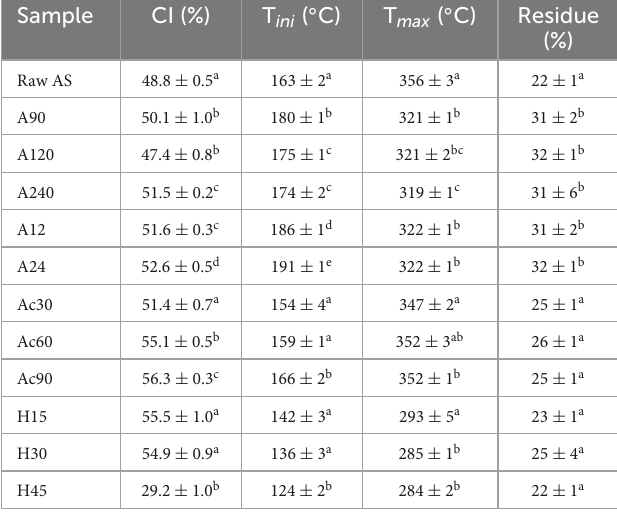
TABLE 3 Crystallinity index (CI) values and thermal degradation parameters obtained by TGA after hydrolysis treatment at different times.